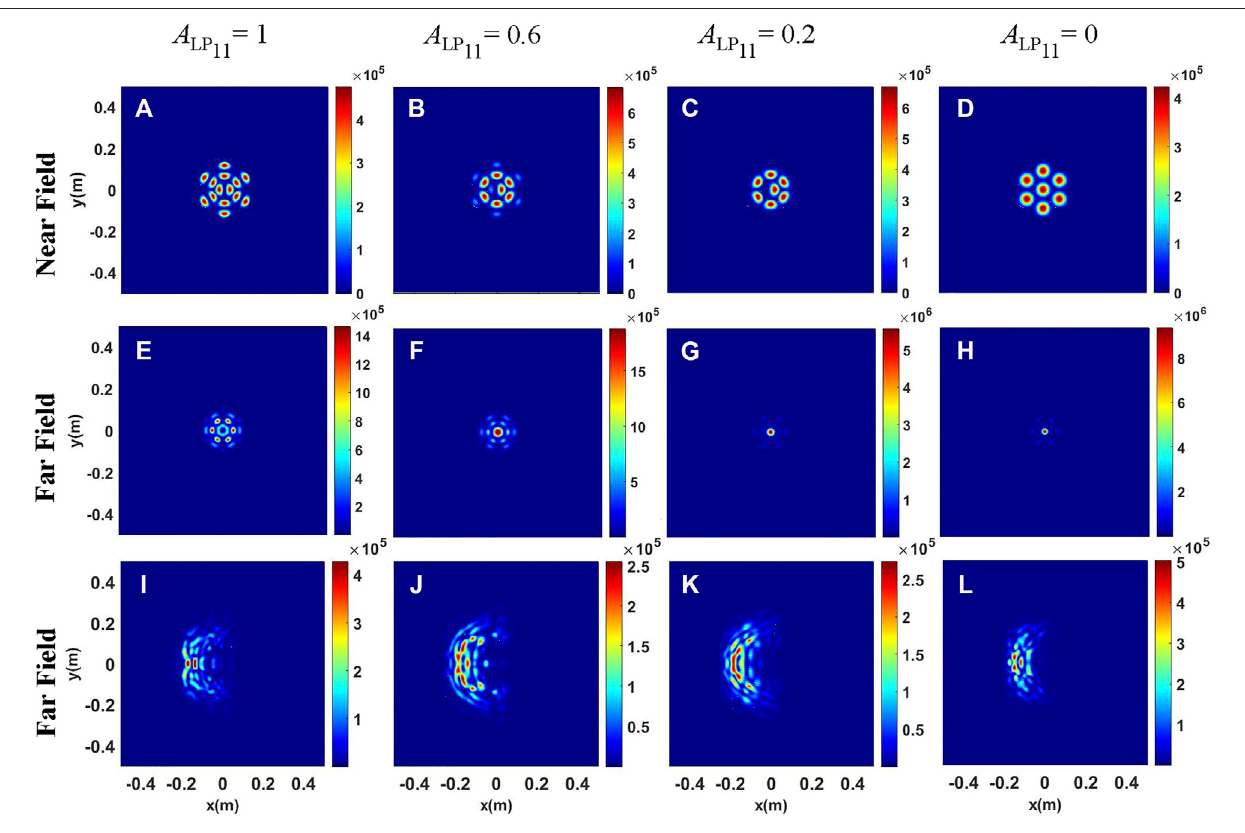
FIGURE 8 | Intensity distributions of the mixed-mode beam array for different content of the LP 01 mode. (A – D) Intensity distributions at the initial plane; (E – H) Intensity distributions at the receiver plane in free space; (I – L) Intensity distributions at the receiver plane under the conditions of thermal blooming.